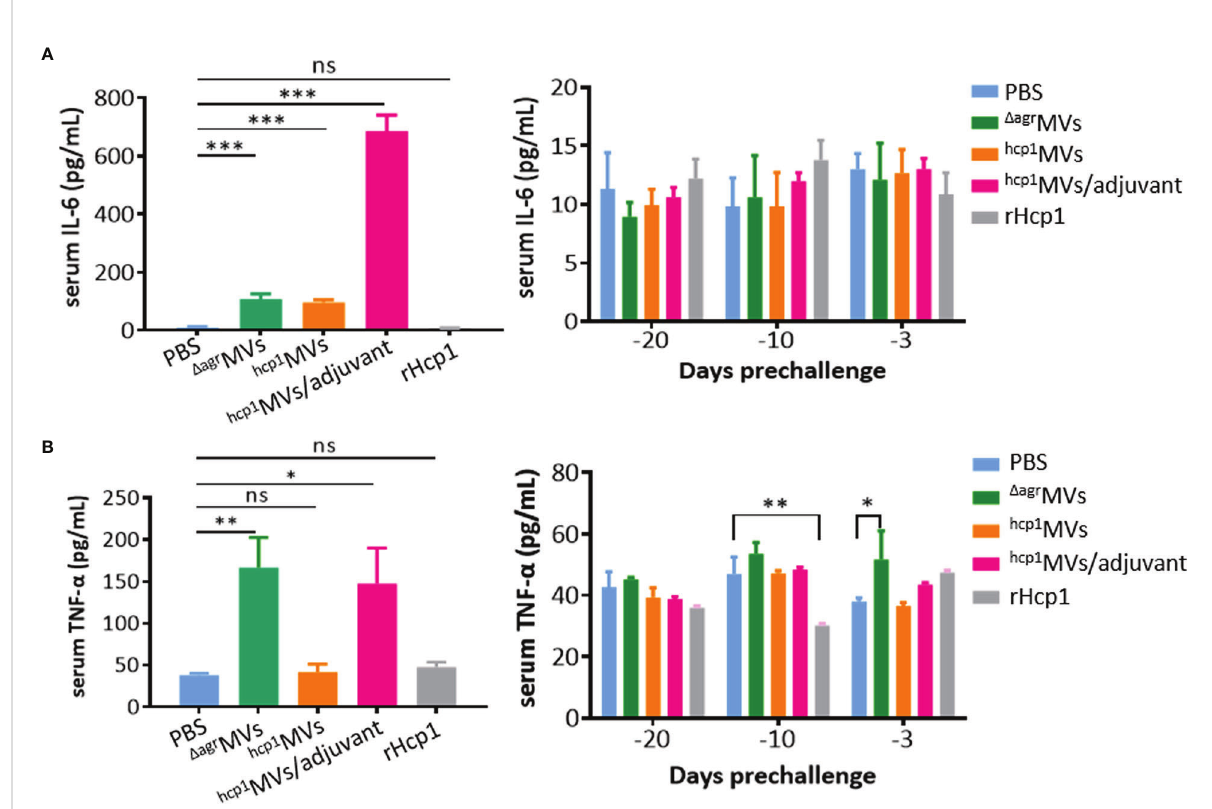
FIGURE 3 In fl ammatory factor production determined by ELISA. BALB/c mice ( n = 3 per group) were each vaccinated with PBS, D agr MVs, hcp1 MVs, hcp1 MVs/ adjuvant, or rHcp1 on days -30, -20, and -10. Serum samples were collected at 6 h after prime vaccination (day -30, left panels) and days -20, -10 and -3 preinfection (right panels). ELISA was performed to quantitate serum IL-6 (A) and TNF- ɑ (B) levels with commercial kits (R&D Systems). The assay was repeated in triplicate. Statistical signi fi cances were calculated by one-way ANOVA; ns indicates no statistical signi fi cance, * P < 0.05, ** P < 0.01, and *** P <